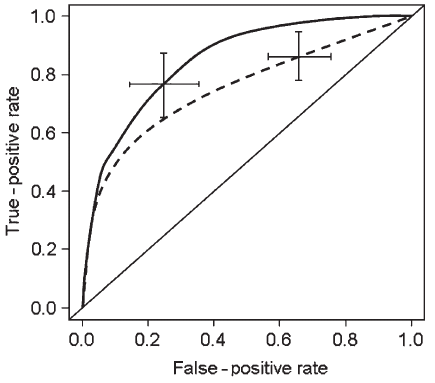
Figure 2. Receiver operating characteristic curve (ROC) output of 10,000 bootstrap procedures of novel (solid line) and Rassi score (dashed line). Lines are average ROC curves and error bars are 95% confidence interval. Note that the novel score [(means±SD) C-statistic: 0.89±0.03; continuous line] showed a non-inferior performance when compared to the Rassi score (C- statistic: 0.80±0.05; P , 0.001 for non-inferiority; dashed line) (see text for